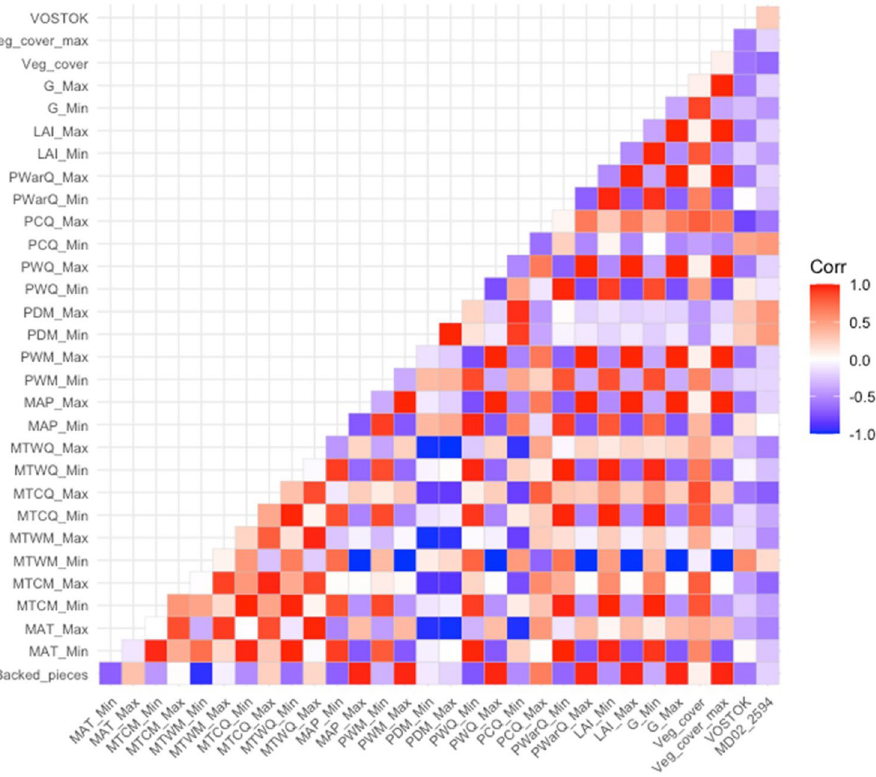
Figure 5. Correlation matrix between environmental, climatic variables and the number of backed artifacts. Color squares indicate significant Spearman rank correlation coefficients (p ≤ 0.05), white squares indicate non- significant correlation coefficients. Where BP stands for backed pieces, MAT_Min mean annual temperature (minimum), MAT_Max mean annual temperature (maximum), MTCMin minimum temperature of the coldest month (minimum), MTCM_Max minimum temperature of the coldest month(maximum), MTWM_Min maximum temperature of the warmest month (minimum), MTWM_Max maximum temperature of the warmest month (Maximum), MTCQ_Min mean temperature of the coldest quarter (Minimum), MTCQ_Max mean temperature of the coldest quarter (maximum), MTWQ_Min mean temperature of the warmest quarter (minimum), MTWQ_Max mean temperature of the warmest quarter (maximum), MAP_Min mean annual precipitation (minimum), MAP_Max mean annual precipitation (maximum), PWM_Min precipitation of the wettest month (minimum), PWM_Max precipitation of the wettest month (Maximum), PDM_Min precipitation of the driest month (minimum), PDM_Max precipitation of the driest month (maximum), PDQ_Max precipitation of the driest quarter (maximum), PWQ_Max precipitation of the wettest quarter (maximum), PCQ_Min precipitation of the coldest quarter (minimum), PCQ_Max precipitation of the coldest quarter (maximum), PWQ_Min precipitation of the warmest quarter (minimum), PWQ_Max precipitation of the warmest quarter (maximum), LAI_Min leaf area index (minimum), LAI_Max leaf area index (maximum), G_ Min greenness (minimum), G_Max greenness (maximum), Veg_Cover vegetation cover (minimum), Veg_cover_ max vegetation cover (maximum), VOSTOK Vostok temperatures, MD022594 Temperatures from MD02-2594. Number of backed artifacts = 513. This figure was created in RStudio 1.4 www. rstud io. com by